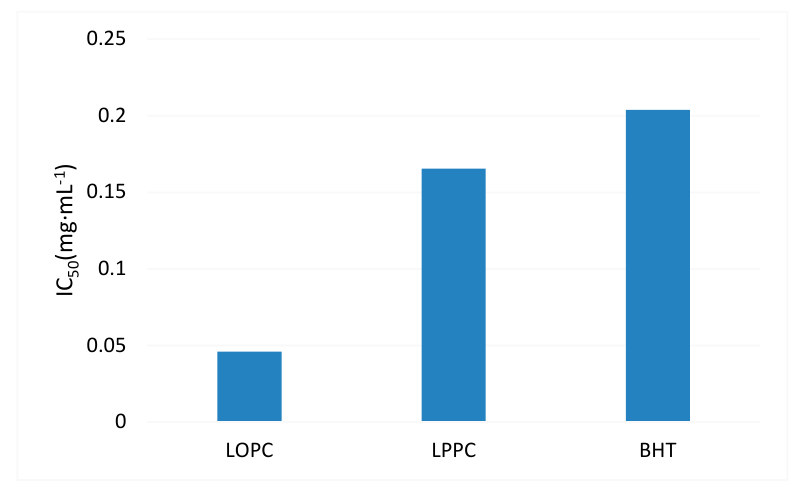
Figure 7. Half-maximal DPPH • free radical scavenging rate (IC 50 ) of BHT, LPPC and LOPC.